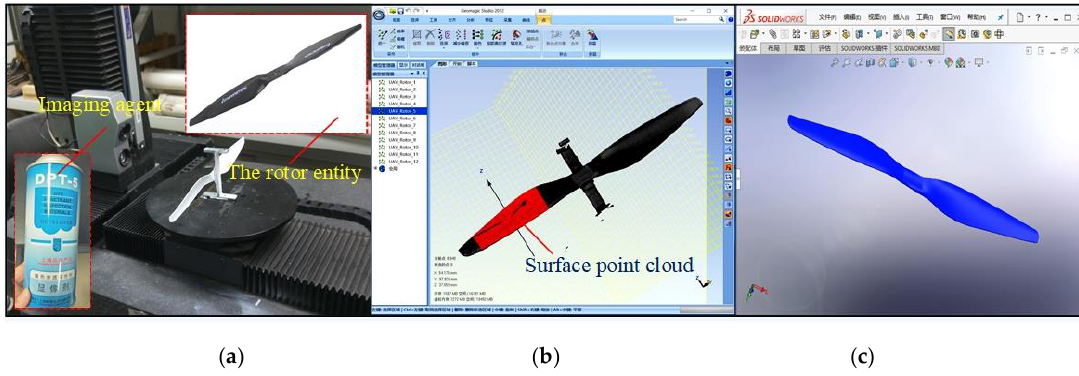
Figure 3. Rotor reverse modeling process. ( a ) Rotor surface scanning; ( b ) Geomagic Studio post processing of point cloud data; ( c ) Solidworks reconstruction rotor diagram.